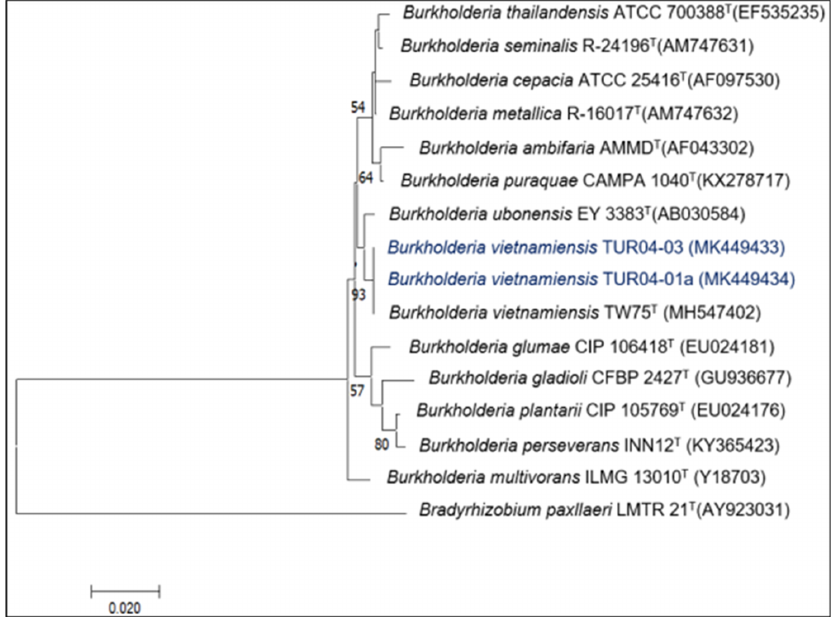
Figure 3. Neighbor-joining phylogenetic tree based on 16S rDNA gene sequences (1258 positions) showing the relationships among endophytes Burkholderia species isolated from rice in Northern Peru and closely related species of the genus Burkholderia . A bootstrap value indicates the signifi ‐ cance of each branch (as percentage) calculated for 1000 subsets (only values greater than 50% are indicated). Bar, two substitutions per 100 nucleotide positions. The 16S rDNA sequence of Bradyrhi ‐ zobium paxllaeri LMTR ‐ 21 T was used as an outgroup.